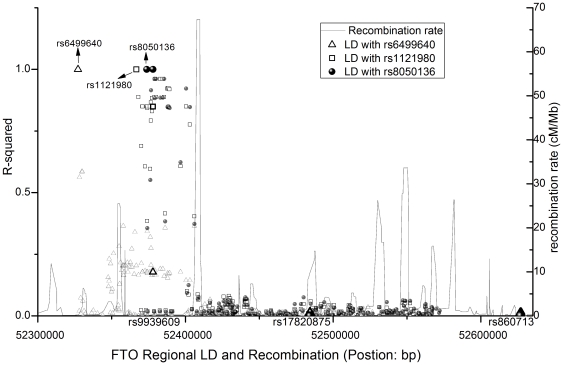
FTO regional linkage disequilibrium (LD) and recombination rate.The LD is from HapMap rel. 27 and the recombination rate is from HapMap rel. 22. SNP position is based on NCBI build 36 of the human genome.